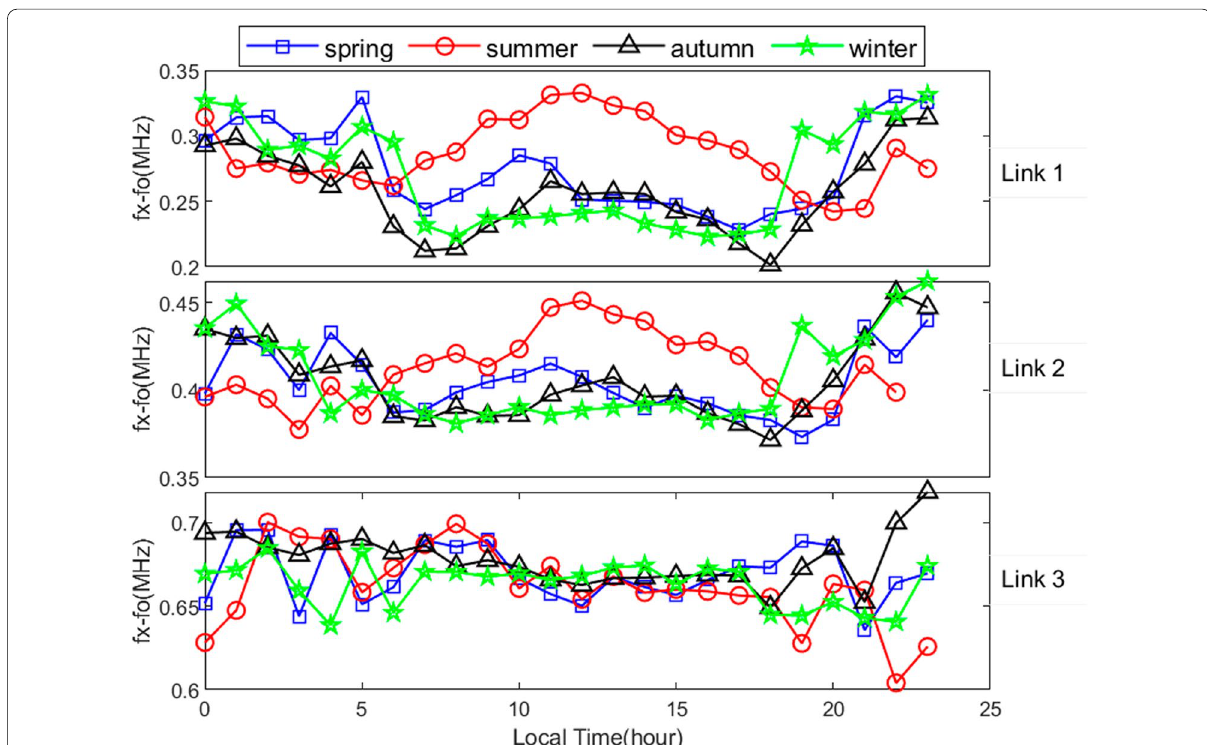
Fig. 5 Seasonal variation of the separations observed through three radio links; blue, red, black, and green lines represent spring, summer, autumn, and winter,